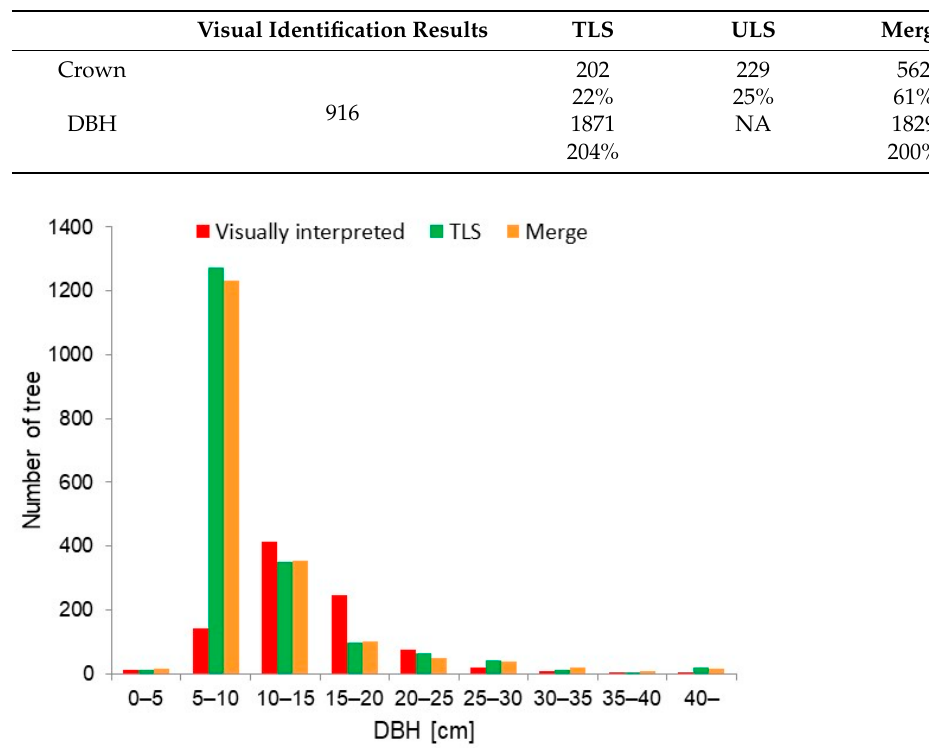
Figure 5. Outcome of tree segmentation. ( a ): A view of the forest point clouds ( b ): The location of identified trees. Table 1. Count of trees identified through tree segmentation.